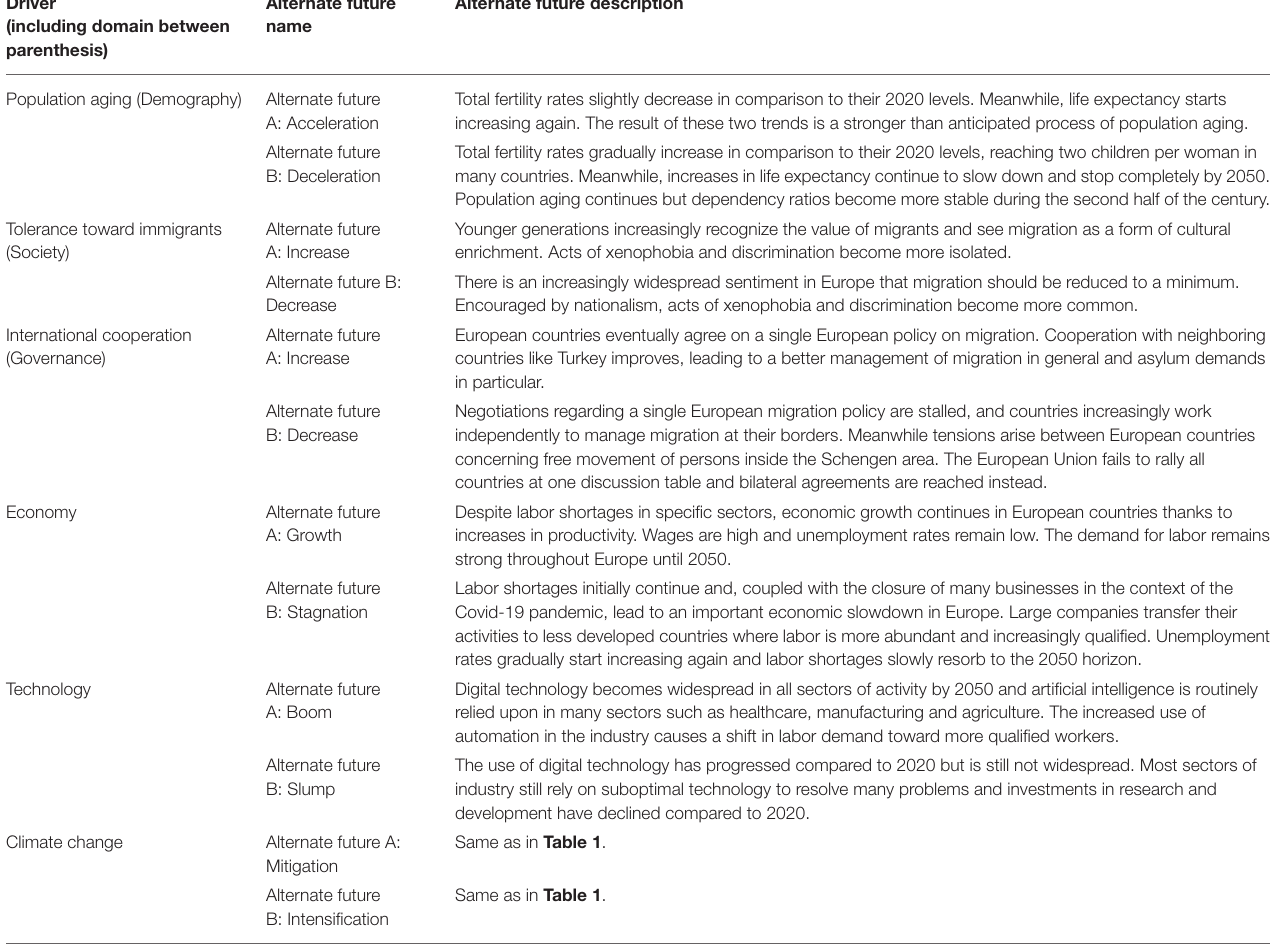
TABLE 3 | Overview of scenarios of change within each domain, Europe.